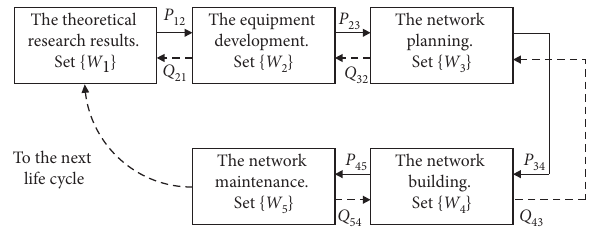
Figure 5: Simplified lifecycle of the telecommunication